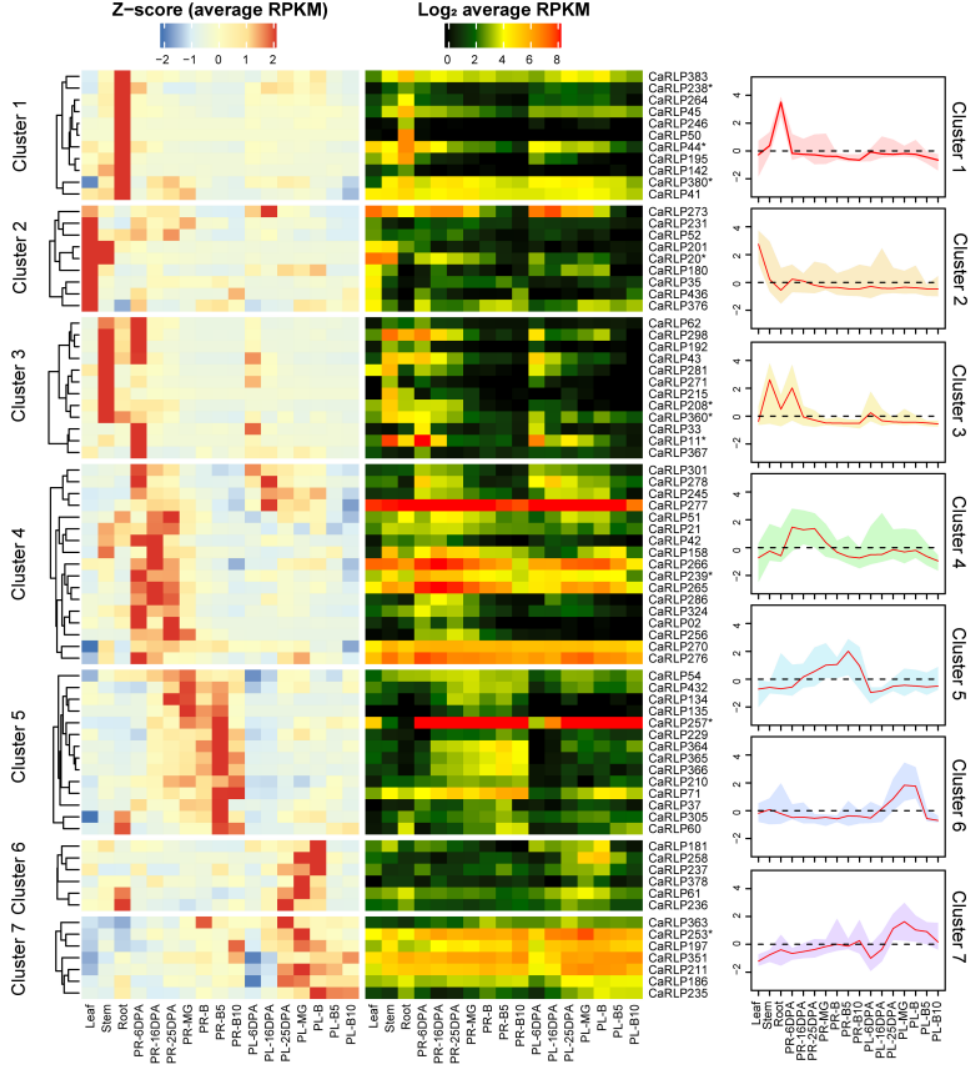
Figure 1. Tissue-specific expression patterns of CaRLPs ( Capsicum annuum receptor-like proteins). The 76 RLP genes out of 438 genes were selected to construct the heat map. Heatmaps on left and right sides are exhibited using the Z-score and RPKM (reads per kilobase of transcript per million mapped reads), respectively. The selected 10 genes for VIGS (virus-induced gene silencing) assay were marked with asterisks in the right side of the heatmap. The graphs represent the Z-score of CaRLPs in each hierarchical cluster, and red lines indicate median Z-score within a cluster. Key: PR, pericarp; PL, placenta; MG, mature green stage; B, breaker stage; DPA, days post anthesis; B5 and 10, 5 and 10 days post-breaker.